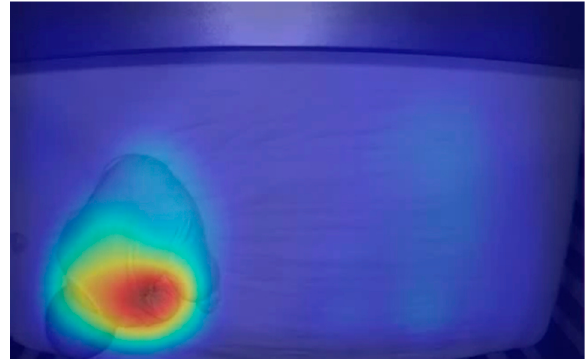
Figure 1. Heat map derived from standard deviation (SD) measures of SD measures showing motion due to breathing. The red region represents high SD measures and the blue region represents low SD measures. The red region was concentrated near the baby’s chest, indicating that the measurement showed motion associated with breathing.